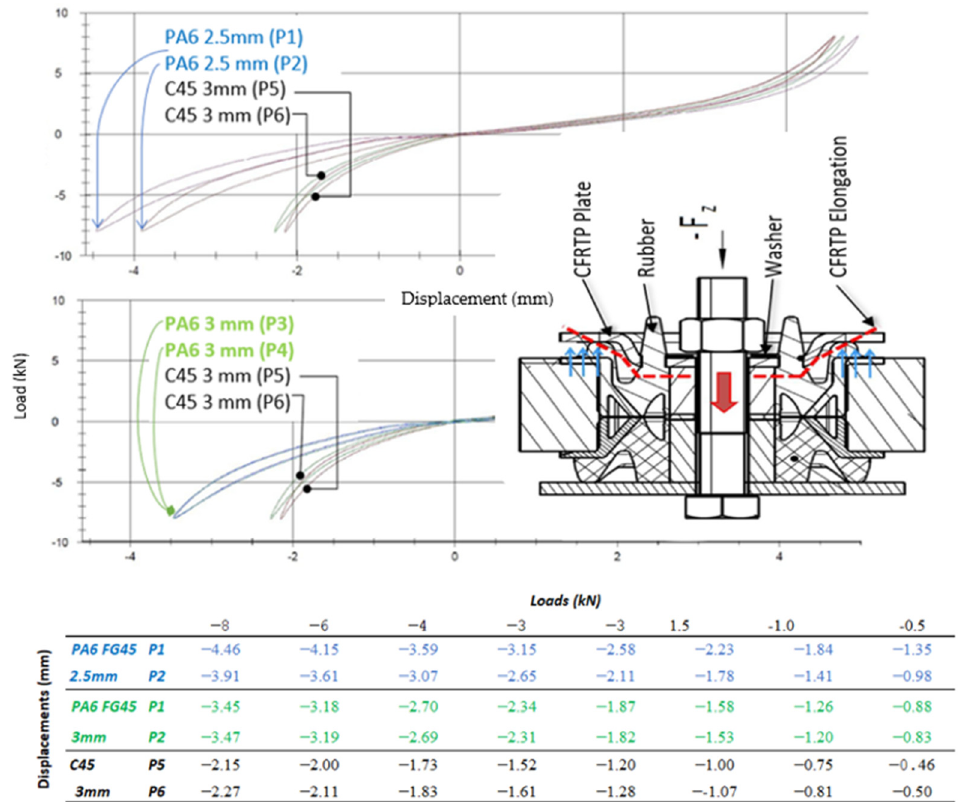
Figure 10. Diagrams of the Axial Static Test (Pre-FAT) of CFRTP and Steel plate deformation caused by Fz